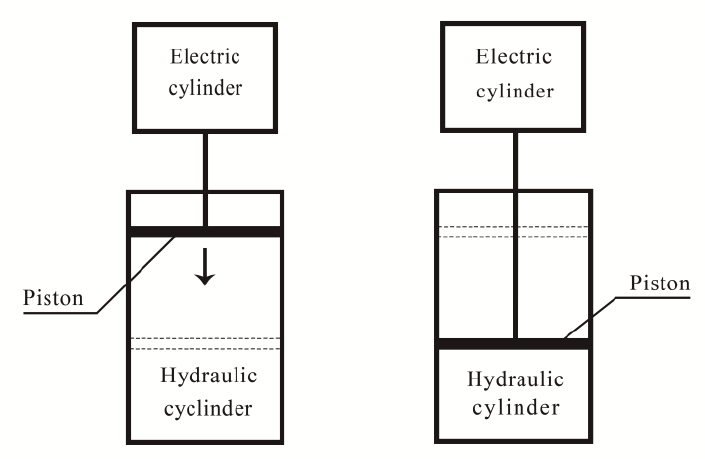
Figure 4. Schematic diagram of the testing principle of seepage flux.